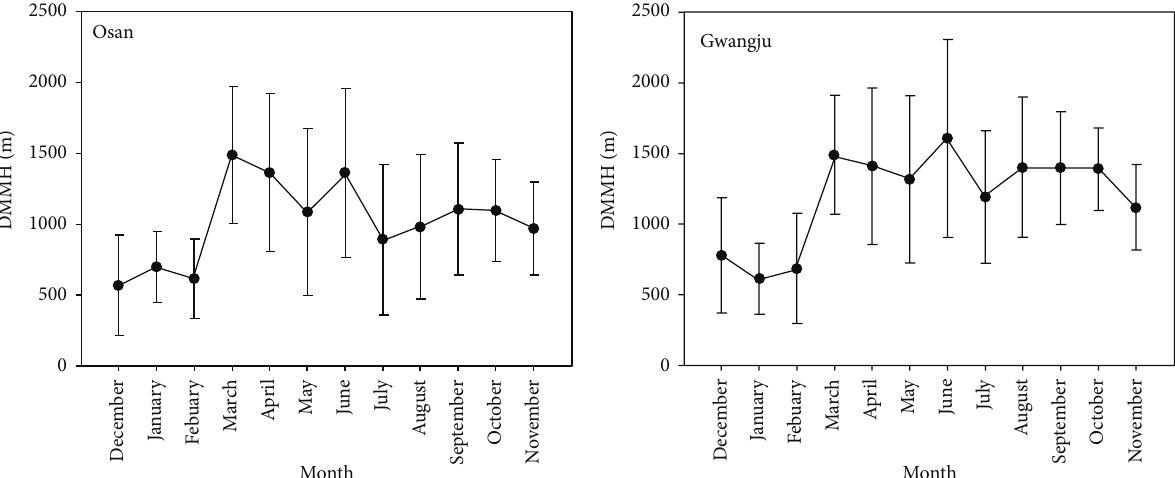
Figure 12: Monthly variation of mean and standard deviation of model DMMH at Osan and Gwangju for one year (June 2010–May 2011), which has re-arranged months for the x -axis